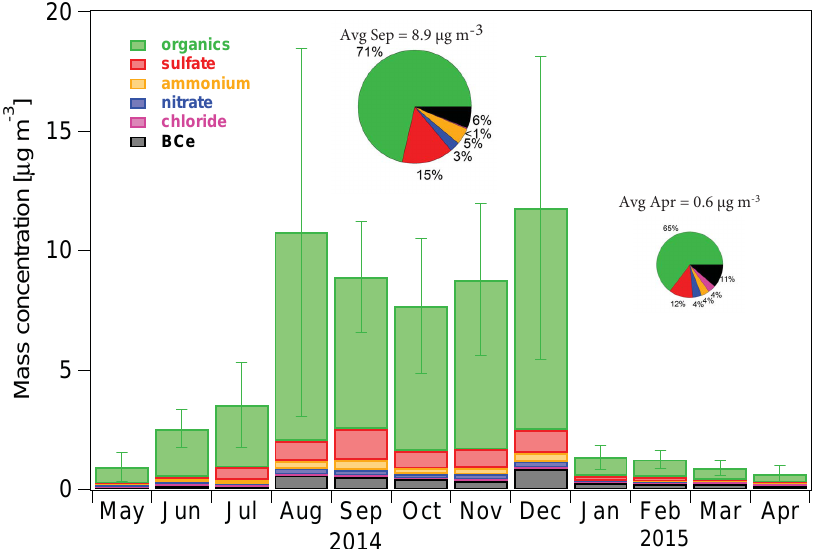
Figure 30. Time series of monthly mean aerosol mass concentrations and chemical speciation at the ATTO site, measured by ACSM from May 2014 to April 2015.